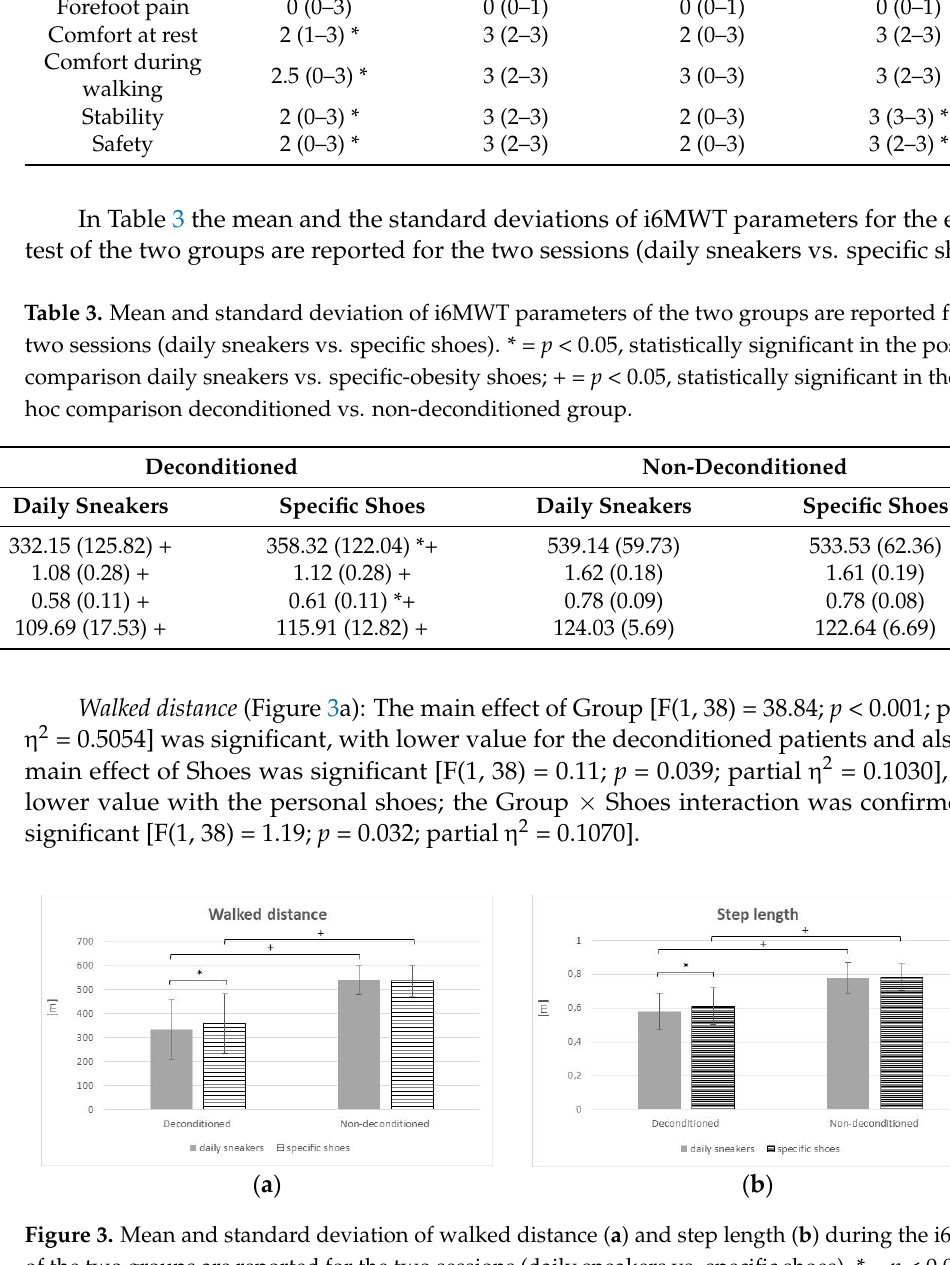
the higher score. In the non-deconditioned group only, stability and safety appeared to